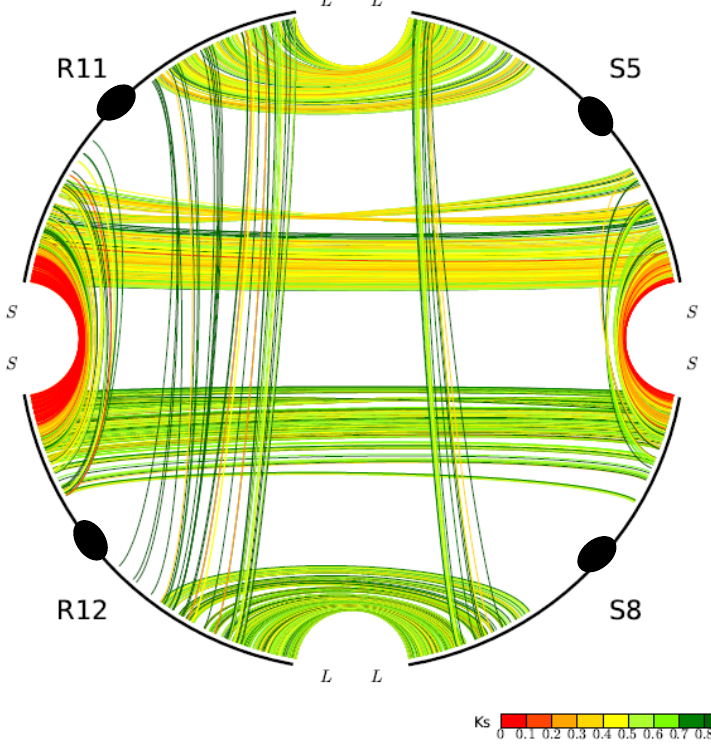
Figure 2. Homology pattern of chromosomes rice chromosomes R11, R12, and their respective sorghum orthologs S5 and S8. Chromosomes are shown with black curved lines, with ovals displaying centromeres. “L” and “S” show long and short arms of the chromosomes. The interior lines show the duplicated genes within genomes and orthologs between genomes. Colors of lines show Ks values (synonymous substitution rates between homologous genes), as illustrated in the right-bottom